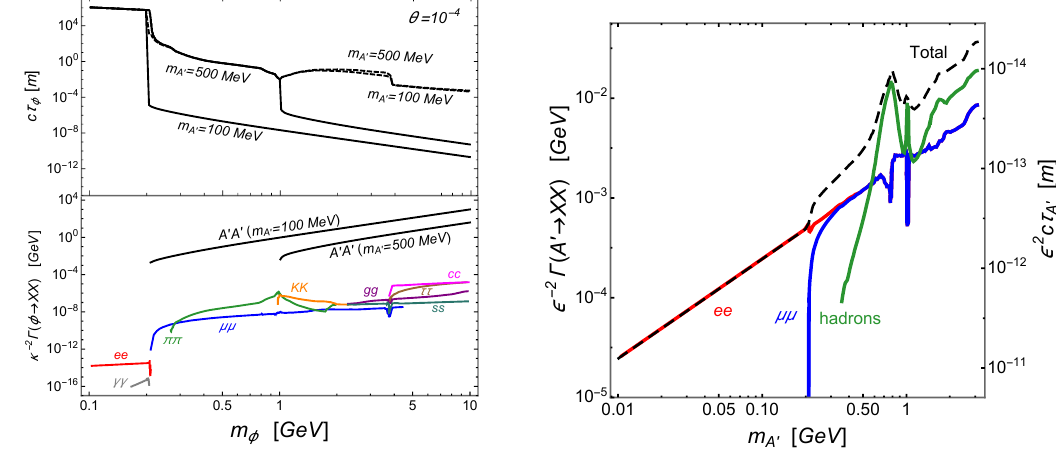
Figure 1 . Left: the decay length (top panel) and partial widths (bottom panel) of the scalar boson. In the left-upper panel, the black solid (dashed) curves are the decay length for m A 0 = 100 and 500 MeV for g 0 = 10 − 4 (10 − 8 ) in the rest frame of φ . The scalar mixing is fixed to be 10 − 4 as an illustrating example. In the left-bottom panel, the color curves are partial decay widths into the SM particles (indicated near each curve). The black solid curves are the partial widths into the dark photons with m A 0 = 100 and 500 MeV. The widths are normalized by the scalar mixing ( κ = θ ) for the SM final states and by the gauge coupling constant ( κ = g 0 ) for A 0 . Right: the decay widths of the dark photon into the SM particles normalized by (cid:15) 2 . The black dashed curve is the total decay width. The right vertical axis is the decay length in the rest frame of A 0 normalized by (cid:15) − 2 . where R ( s ) ≡ σ ( e + e − → hadrons) /σ ( e + e − → µ ¯ µ ) , being s the center of mass energy, i.e. m for the decay. The decay width (left axis) and length (right axis) of the dark A 0